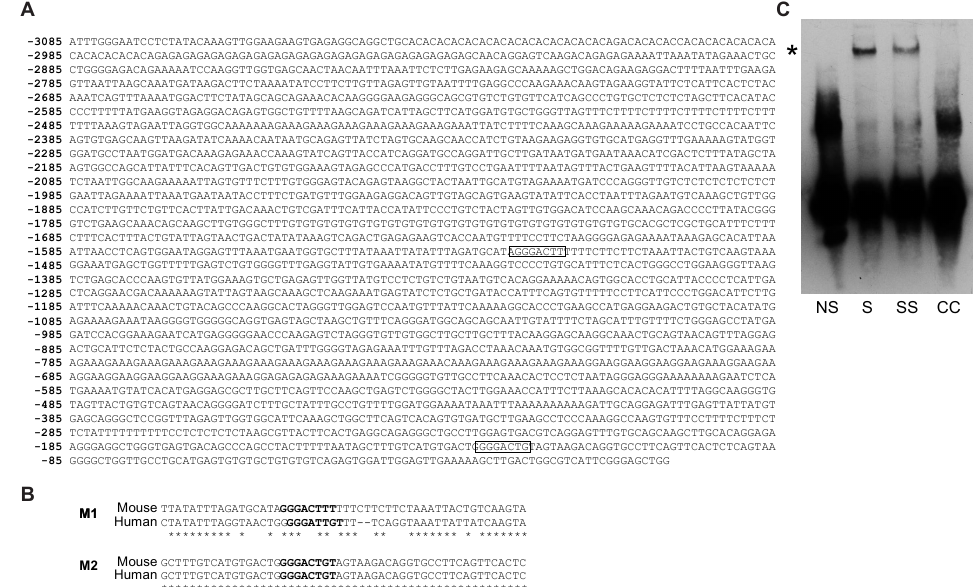
Figure 2. The PGC-1α gene promoter. ( A ) NF-κB p65 binding sites (boxes) in the 3 kb proximal mouse PGC-1α promoter are indicated. The binding site at -1522 is denoted as M1, while the site at −127 is M2. Numbers denote location in nucleotides relevant to the PGC-1α ATG start codon. ( B ) The region flanking the putative M1 and M2 p65 binding sites (boldface) is depicted; the M2 site exhibits complete conservation between the mouse and human PGC-1α gene promoters, whereas the M1 site is relatively poorly conserved (<70%); * denotes nucleotide identity. ( C ) Electrophoretic mobility shift assay for NF-κB p65 binding to the PGC-1α promoter. Asterisk (*) denotes shifted protein–oligonucleotide complex. NS, non-shifted control lacking cell lysate; S, shifted sample containing p65-transfected cell lysate; SS, super-shift containing p65-transfected cell lysate and anti-p65 antibody; CC, lysate including cold competition (200x unlabeled oligonucleotides).